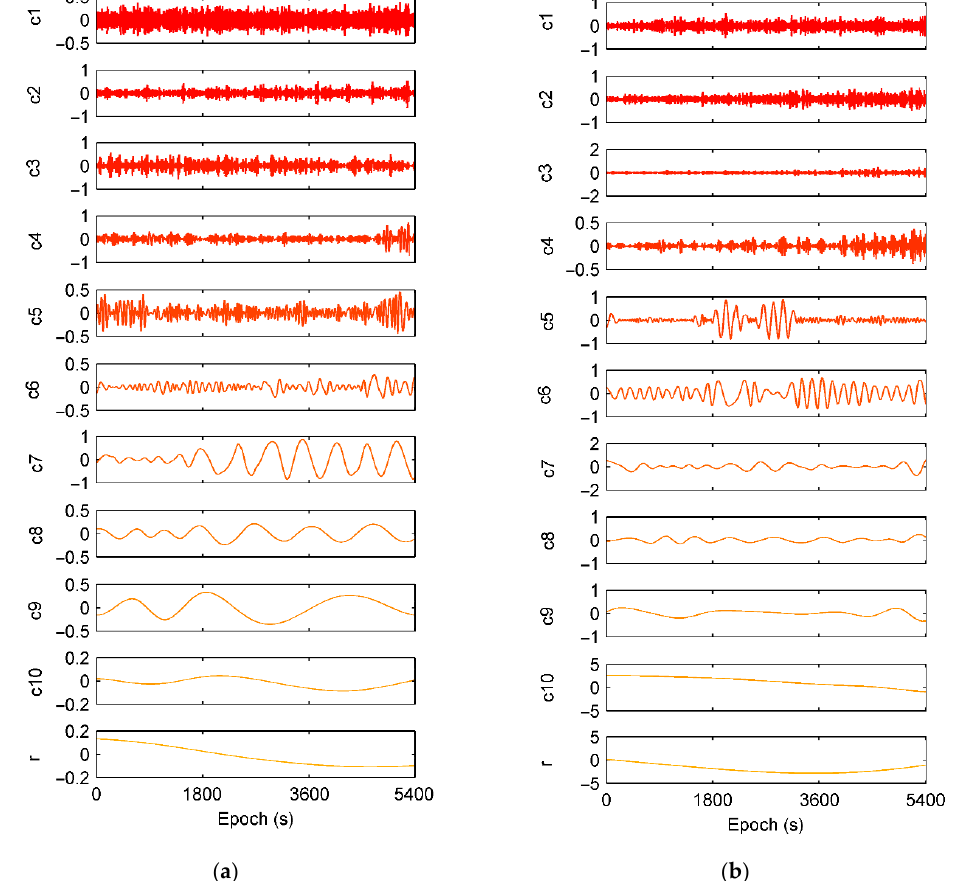
Figure 8. Decomposed layers for CMC using EMD approach. ( a ) C09 and ( b ) G19.